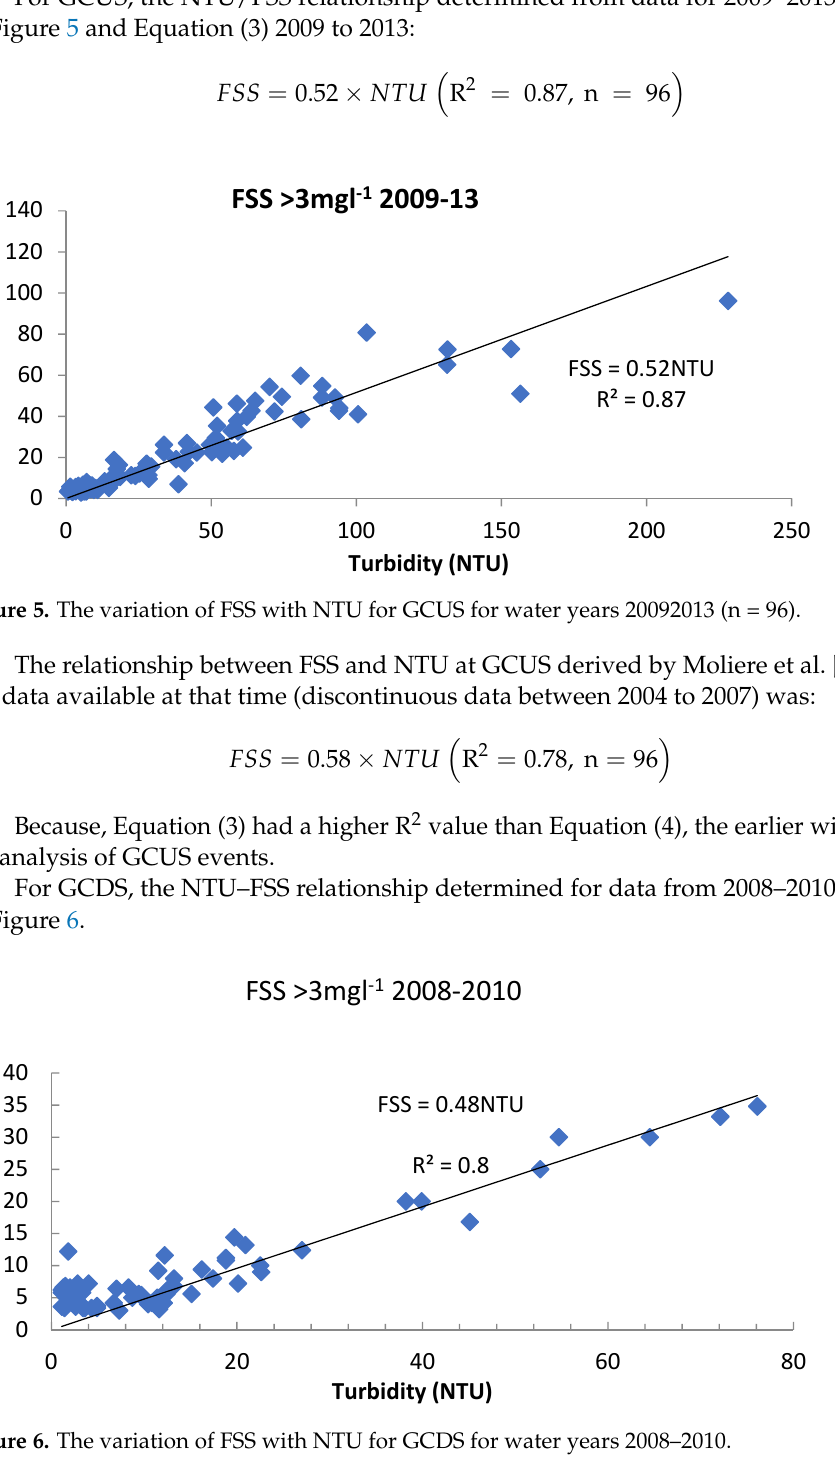
lationships can vary between instruments, sites and over time. The FSS–NTU relationships for GCUS, GCDS, MCUS, and MCDS derived with the available data are presented below.